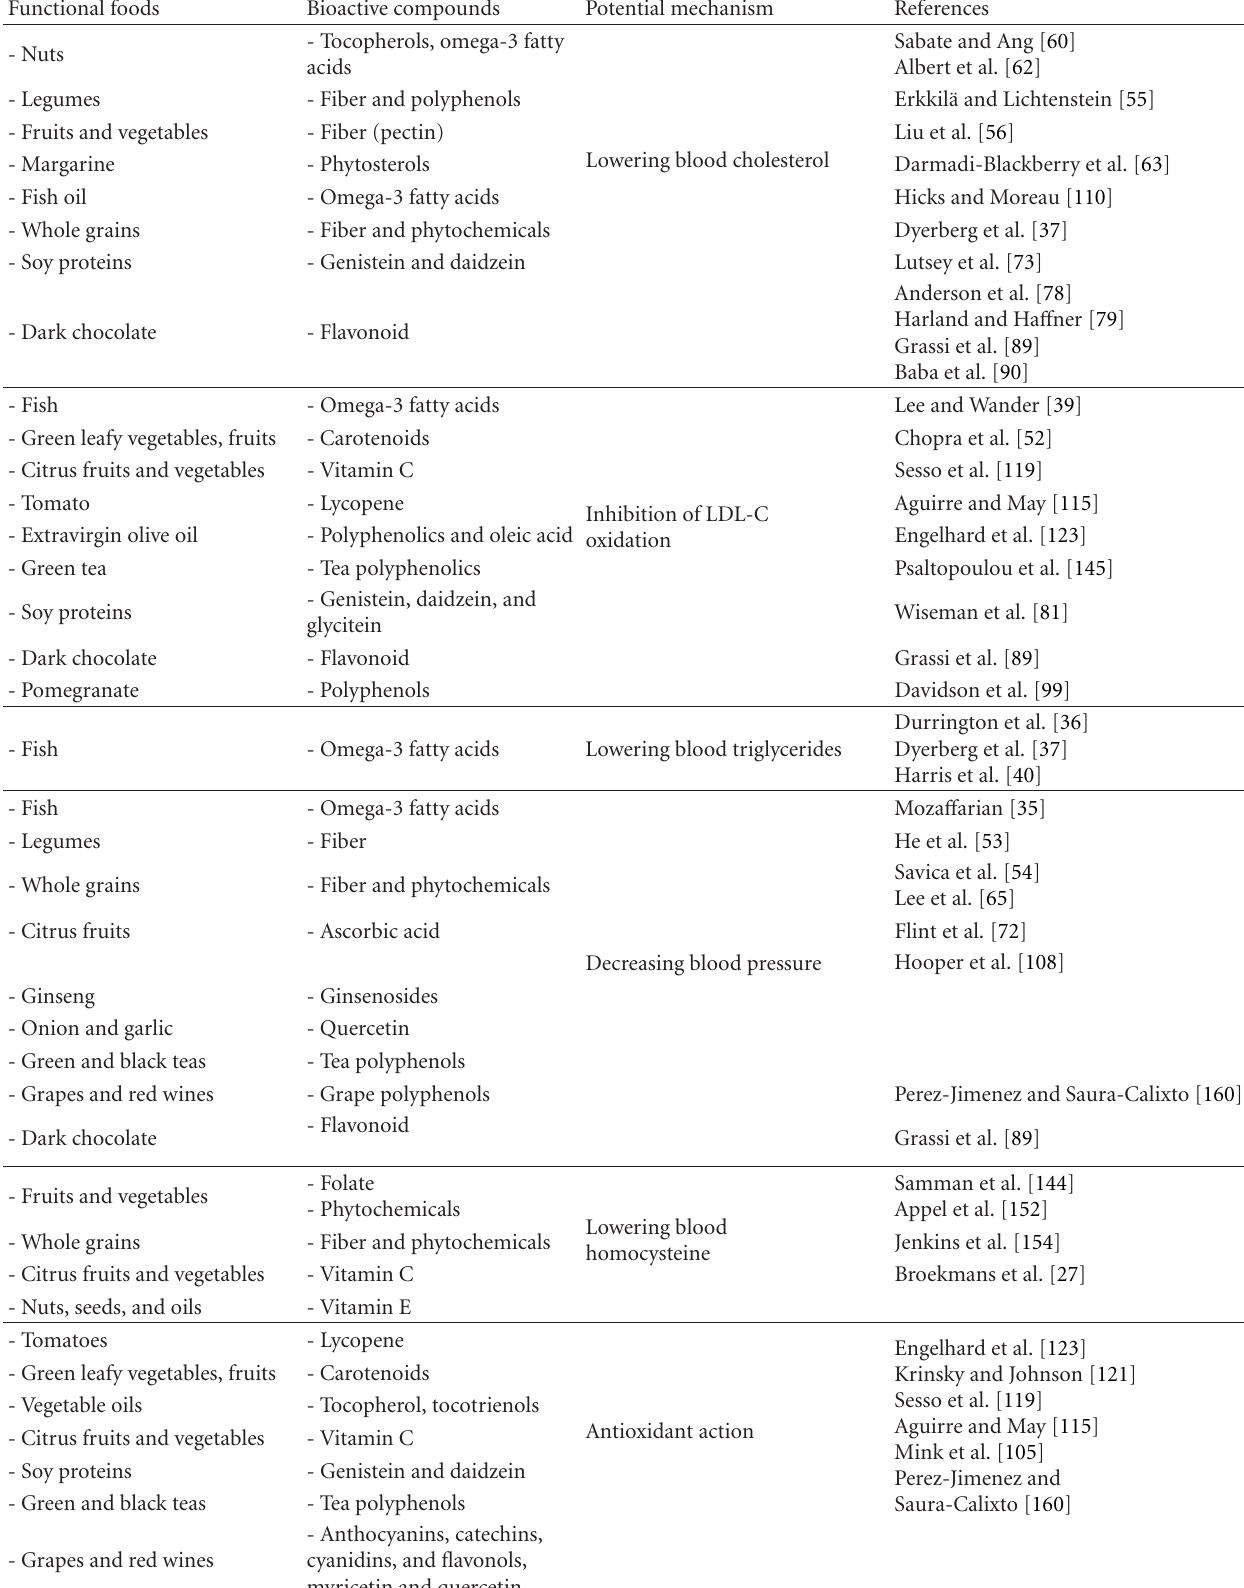
Table 2: Potential cardiovascular protective e ff ects of functional